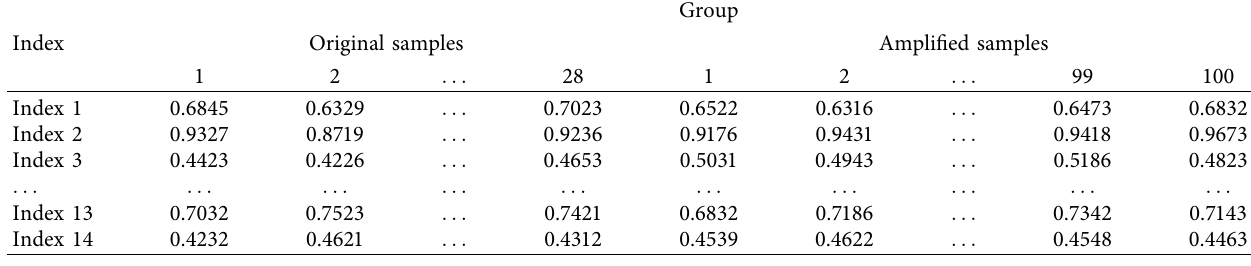
Table 2: Normalized original sample set and amplified sample set.